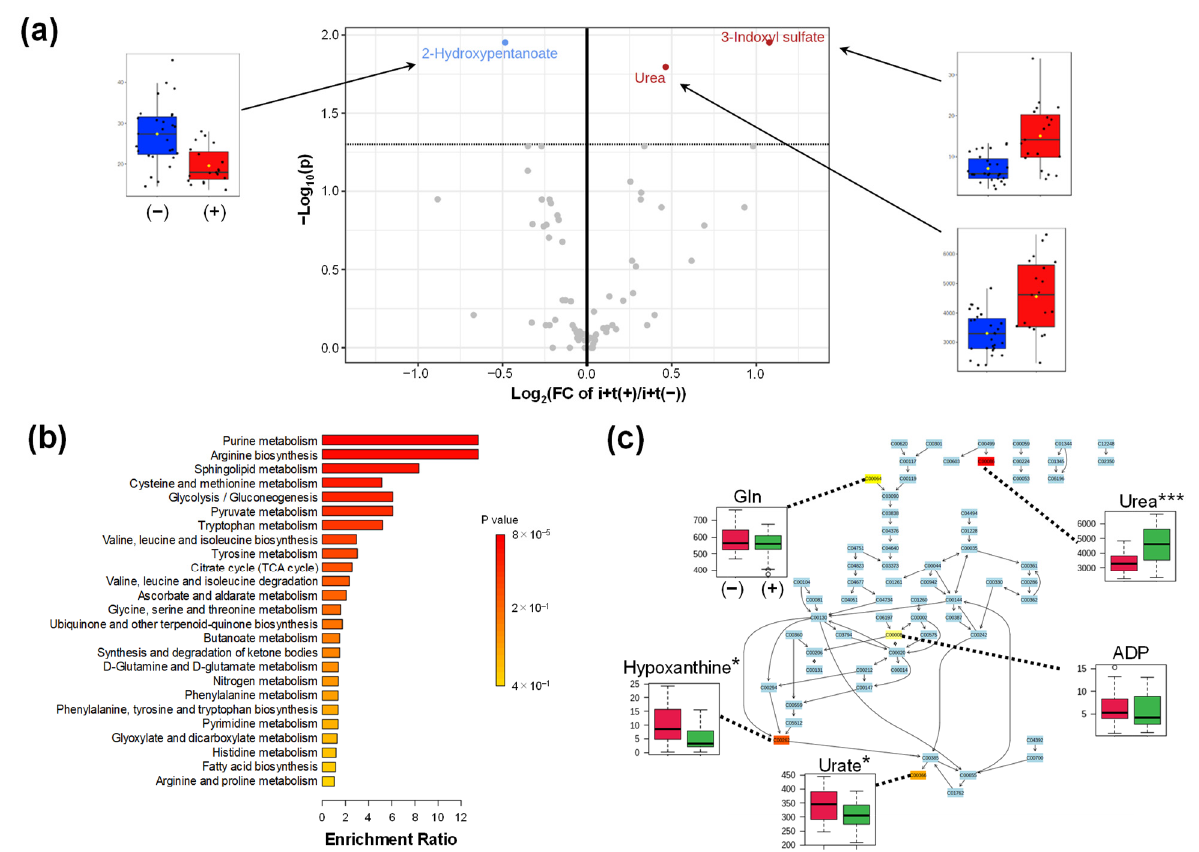
Figure A2. The difference in the metabolomic profile of participants with kidney transplantation (groups i + t (+) and i + t ( − )). ( a ) Volcano plots. The x -axis indicates the log 2 -fold change (FC) of i + t (+)/i + t ( − ). The y -axis shows the − log 10 (P) of each metabolite. False discovery rate (FDR)-adjusted p -value was cal- culated using the Mann–Whitney test. Metabolites showing p < 0.05 with FDR correction are shown using box plots. Red and blue box plots show the data of groups i + t (+) and i + t ( − ), respectively; ( b ) Enrichment analysis; ( c ) Purine metabolism showing the largest − log 10 (P) value by the pathway anal- ysis. Green and red box plots show the data of groups i + t (+) and i + t ( − ), respectively. * p < 0.05 and *** p < 0.001.